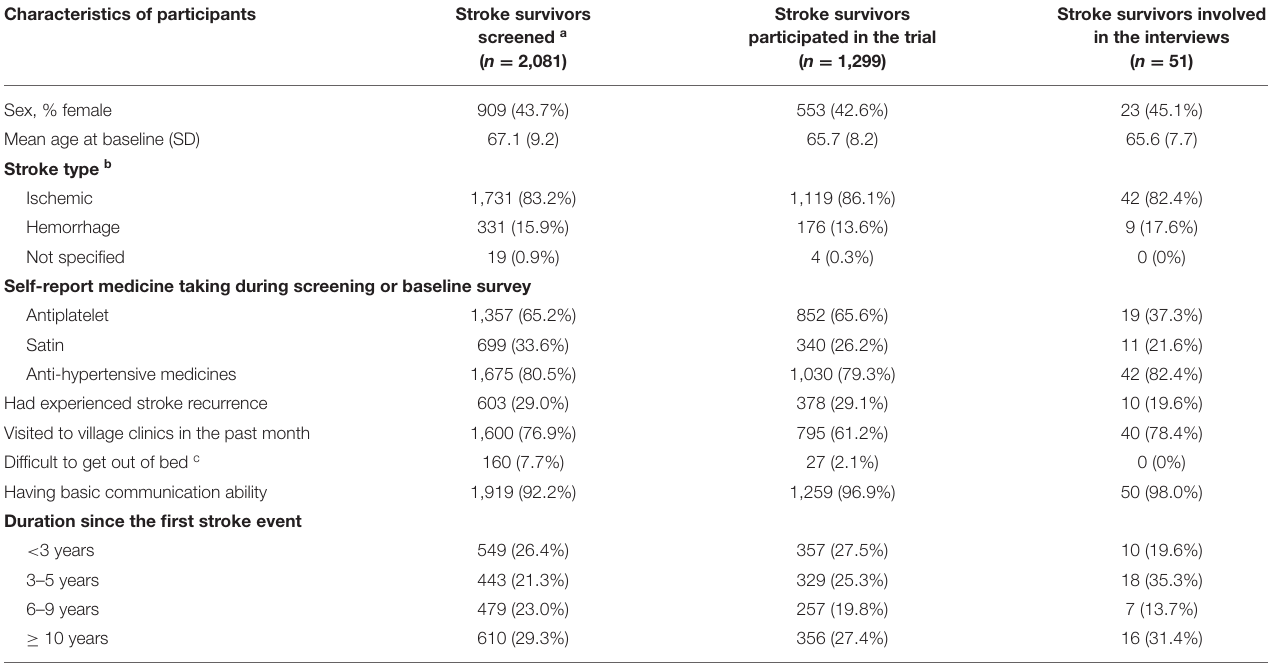
TABLE 2 | The characteristics of the participants who were involved in the screening, recruited in the trial, and participated in the in-depth interviews. Characteristics of